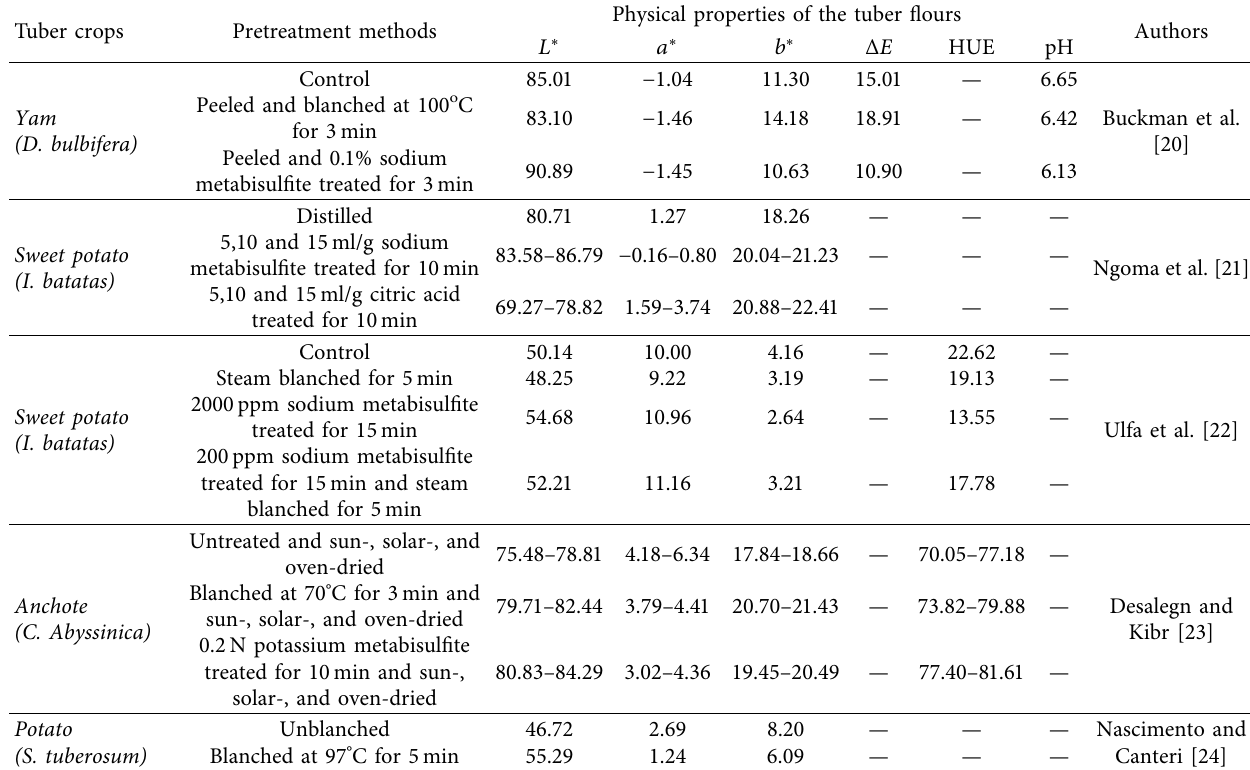
Table 1: Review on the effects of pretreatments on the physical properties of tuber. Tuber